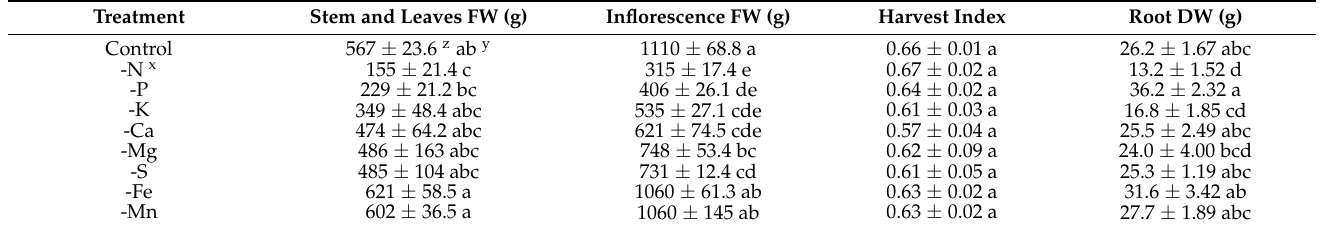
Table 5. Fresh weight (FW) of separated aboveground tissues, harvest index (inflorescence FW/stem and leaves FW), and the dry weight (DW) of the roots from each nutrient treatment. Treatment Stem and Leaves FW (g) Inflorescence FW (g) Harvest Index Root DW